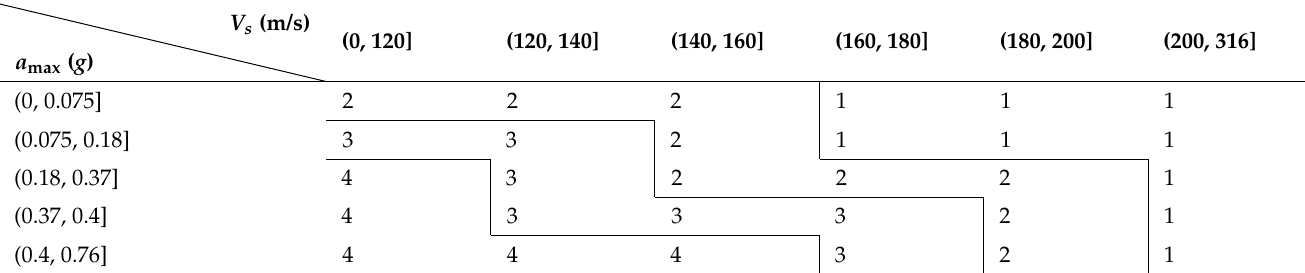
Table 6. Criteria table of liquefaction potential grade.